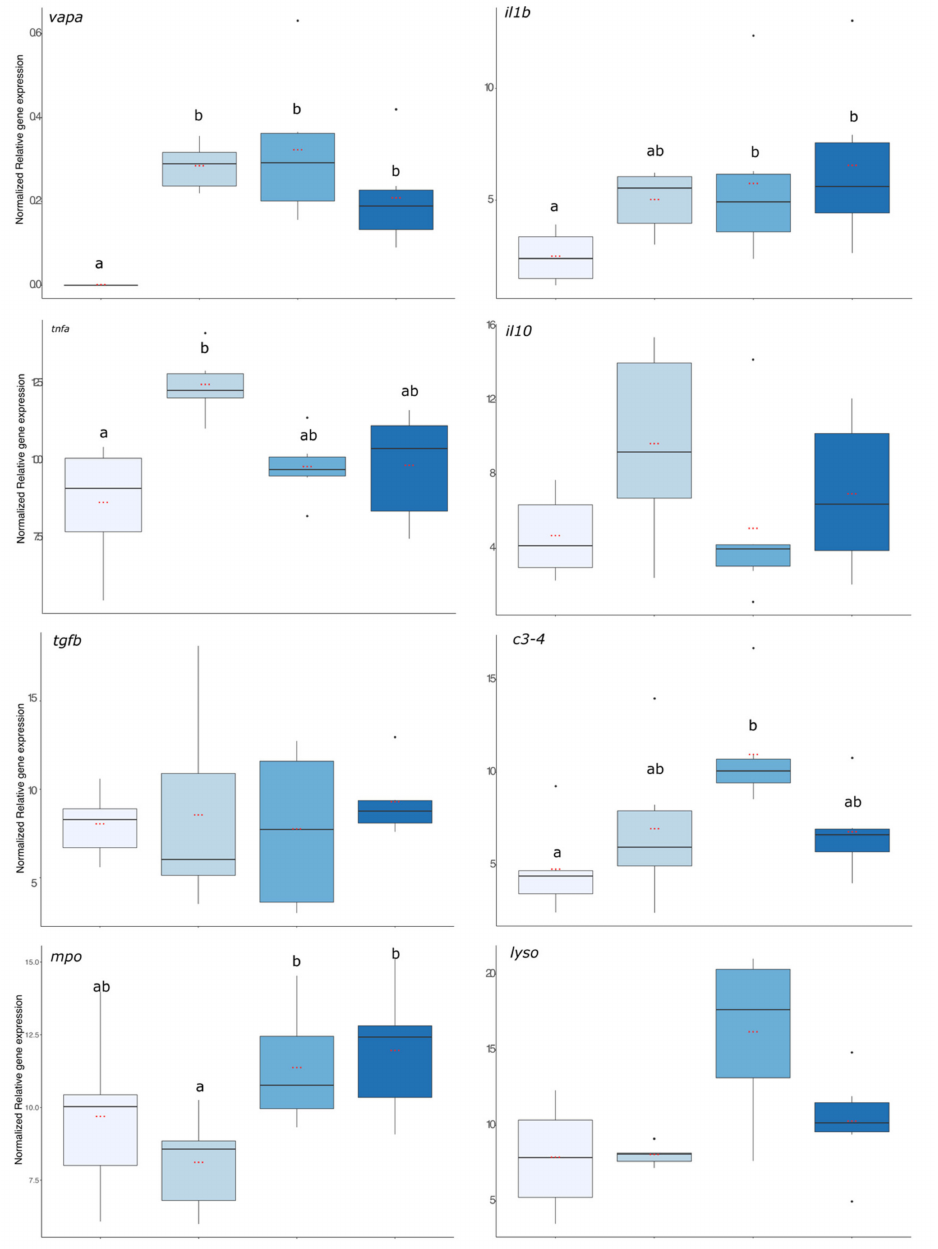
Figure 5. Evaluation of the immune status of rainbow trout through qPCR on head kidney in group before the infection and after bacterial infection (6, 24, and 72 hpi). The graphs represent vapa, il1b, tnfa , il10, tgf β , c3-4 , mpo , and lyso mRNA expressions. Letters (a and b) on the top of the plot represent the significance between groups and the three red dots in the boxplot represent the mean of the associated group. The black dot represents outlier